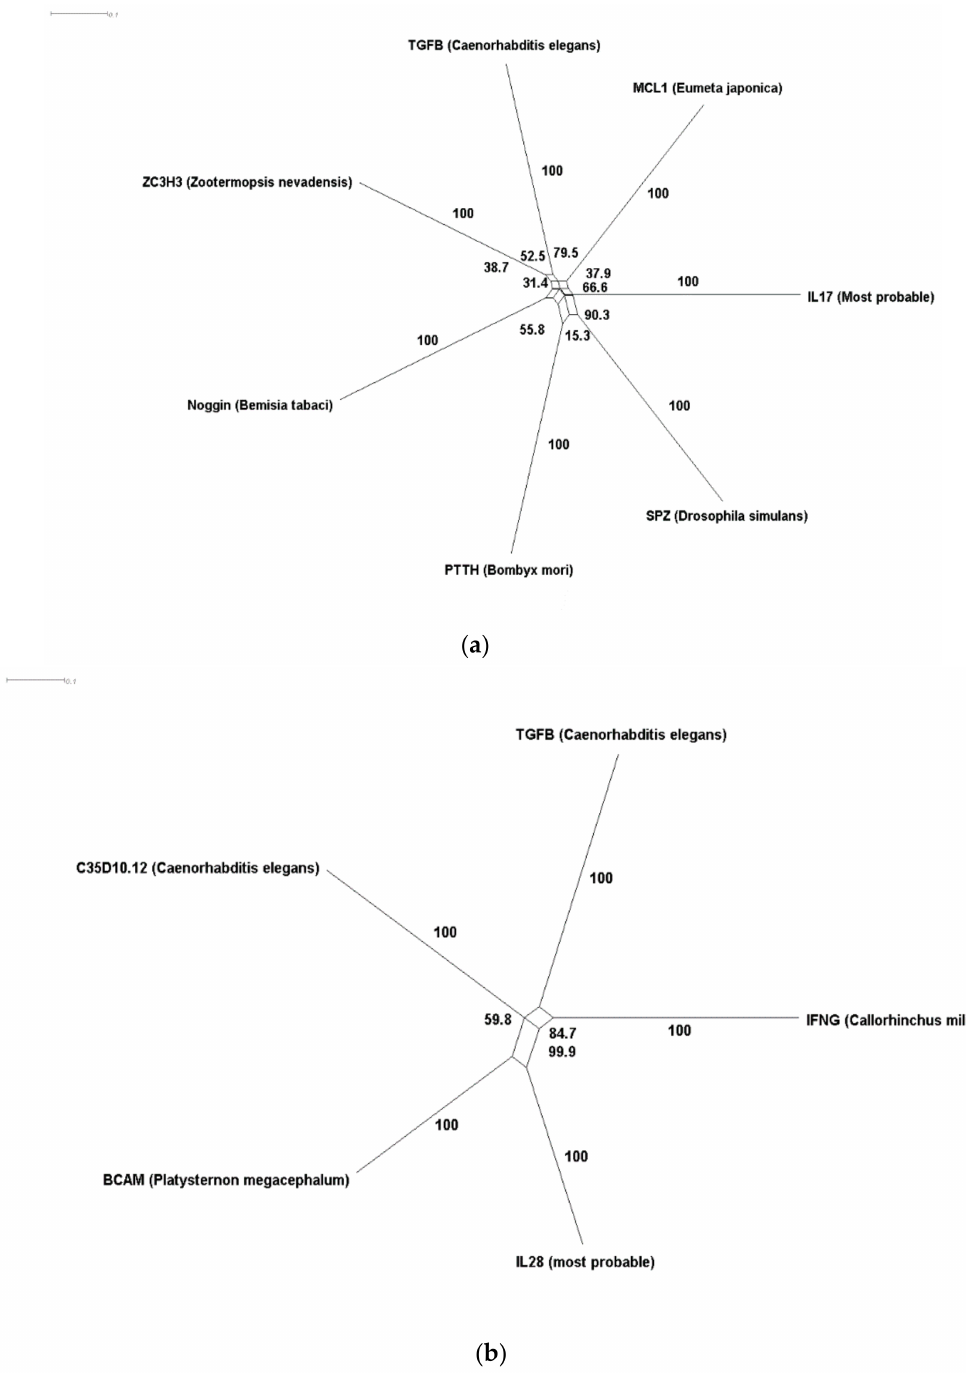
Figure 3. ILs and IL receptors do not share a sole origin. For each IL and IL receptor family, we identified the highest probable common ancestors using HHsearch and Blastp. Then we employed SplitsTree to estimate an evolutionary network with a bootstrap value of 100 using the identified sequences. ( a ) IL17 super family evolutionary network. Our workflow identified six different proteins as putative homologs to the ancestor sequence of IL17, namely, MCL1, SPZ, TGF β , PTTH, Noggin, and ZC3H3. The nearest two homologs to IL17 are SPZ and MCL1. SPZ first appeared in Drosophila , while MCL1 appeared in Bagworm moth. ( b ) The nearest homologs of IL28 are IFN γ (Elephant shark), BCAM (Bighead turtle), C35D10.12 (Round worm) and TGF β (Round